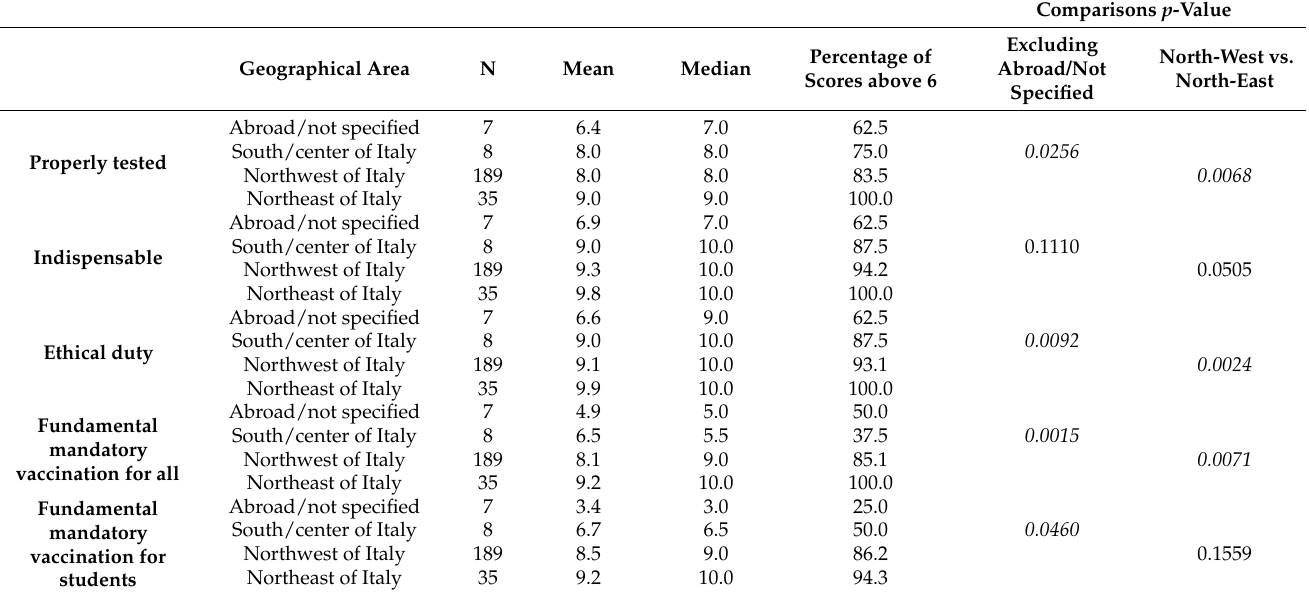
Table 4. Degree of agreement with statements on importance of vaccination and attitude toward mandatory vaccination, by geographical